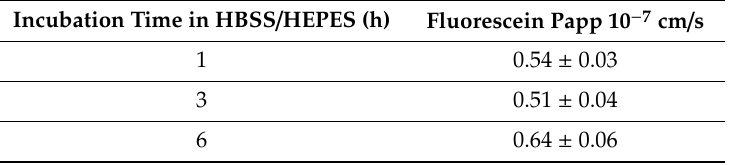
Table A3. Apical-to-basal fluorescein permeability measured across a Calu-3 cell epithelium model after 6 h of incubation of the apical side monolayer in the presence of the transport medium only (HBSS bu ff ered at pH 7.4 with 10 mM